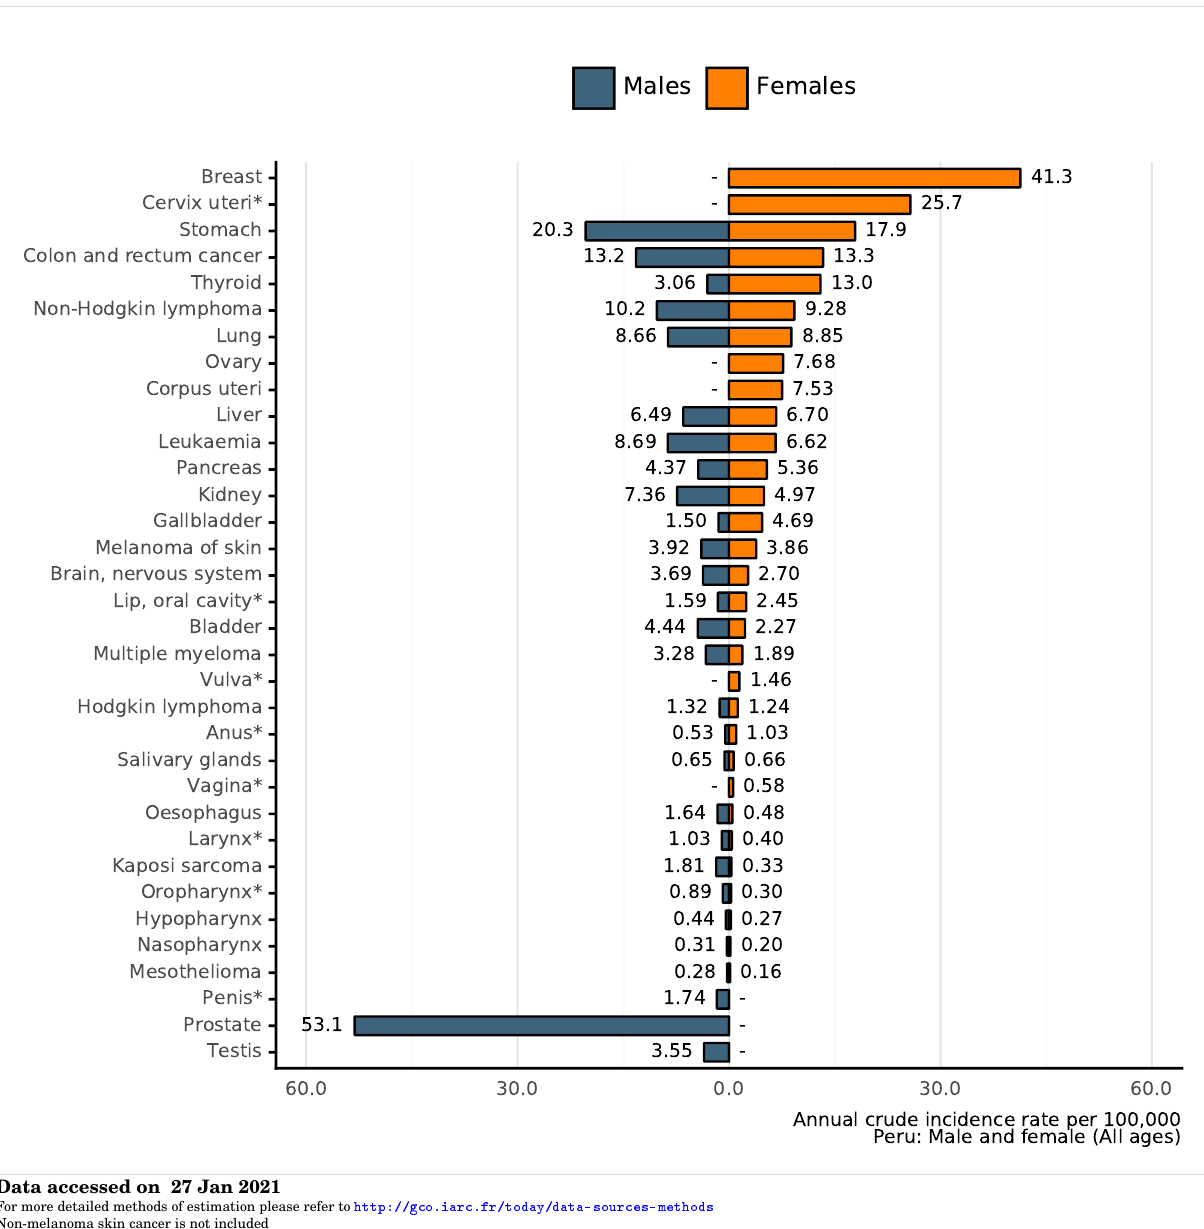
Figure 4: Comparison of HPV related cancers incidence to other cancers in men and women of all ages in Peru (estimates for